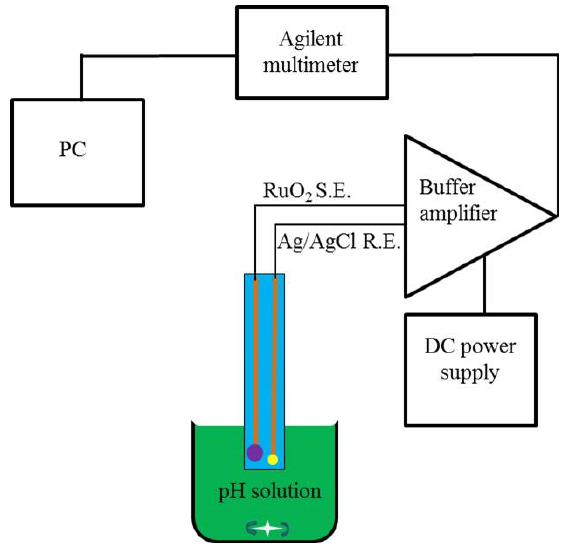
Figure 2. Schematic representation of potentiometric measurement setup (S.E.—sensing electrode; R.E.—reference